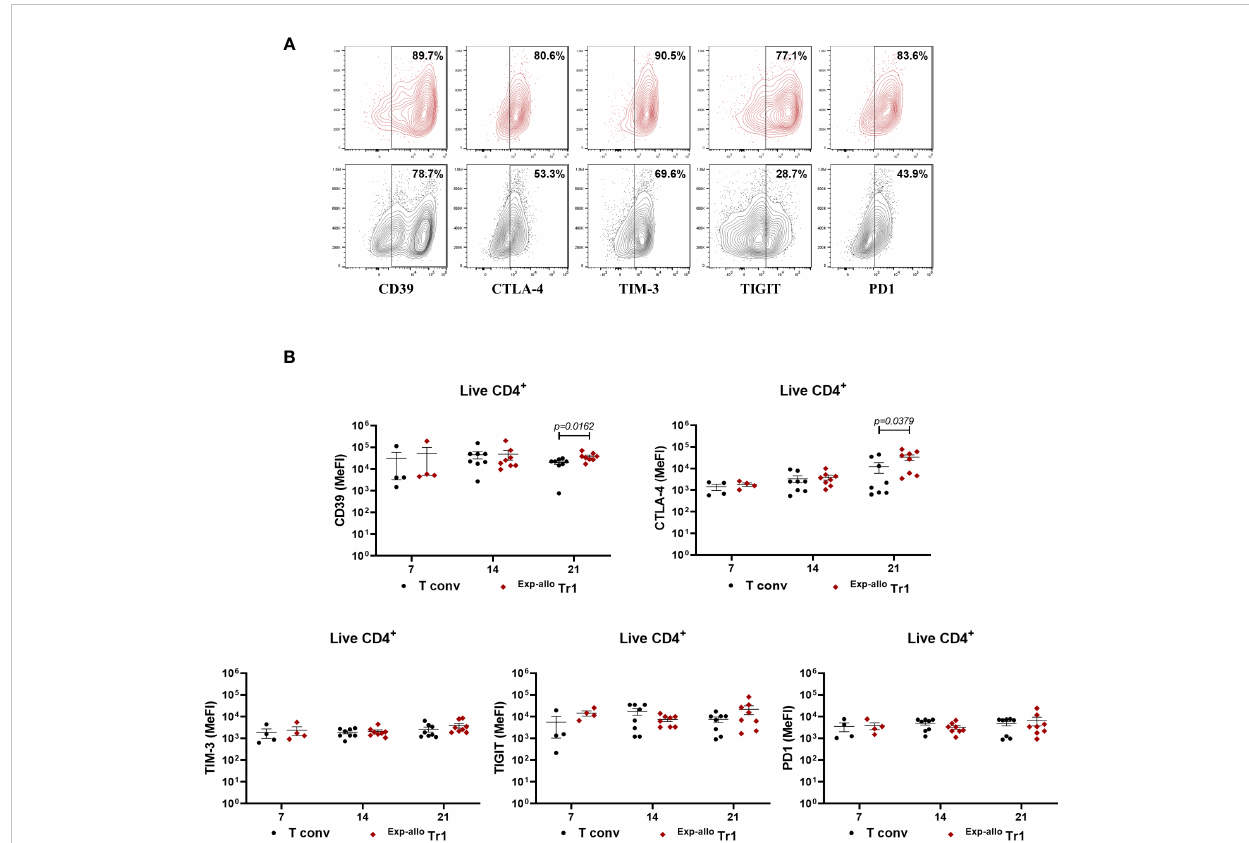
FIGURE 4 Long-term Exp-allo Tr1 cells maintain a high expression of co-inhibitory receptors. Puri fi ed Allo Tr1 cells were polyclonally expanded for 21 days and the expression of co-inhibitory receptors were evaluated. (A) Representative contour-plot of expression of co-inhibitory receptors in Exp-allo Tr1 cells (red) and Allo T conv (black). (B) Levels of expression (MeFI) of TIM-3, TIGIT, PD1, CTLA-4 and CD39 in Exp-allo Tr1 (red, n= 4-8) and Allo T conv (black, 4-8) at day 21 of stimulation. All experiments were performed in duplicates. Data are representative of six independent experiments. The results are shown as mean ± SEM. The statistical analysis were performed using an unpaired-t test or the Mann – Whitney U